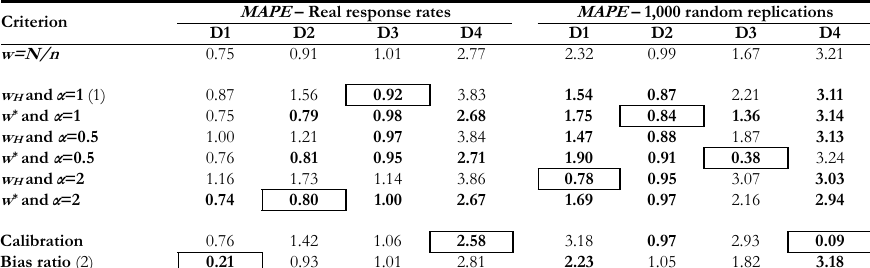
Comparison between results obtained using the real response rates and simulated 50% response rates (1,000 random replications); results derived from calibration and bias ratio criteria (wholesale trade: average of 2007 estimates) MAPE – Real response